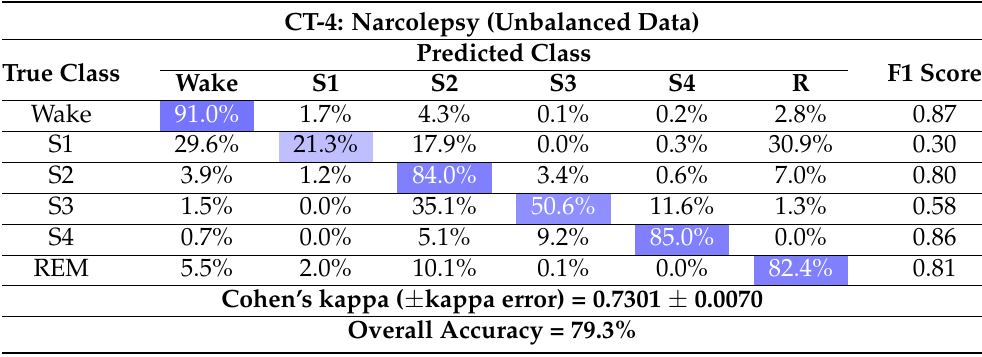
Table 15. Confusion matrix corresponding to sleep stage classification of narcolepsy patients with unbalanced data using the EBT classifier with 10-fold CV.